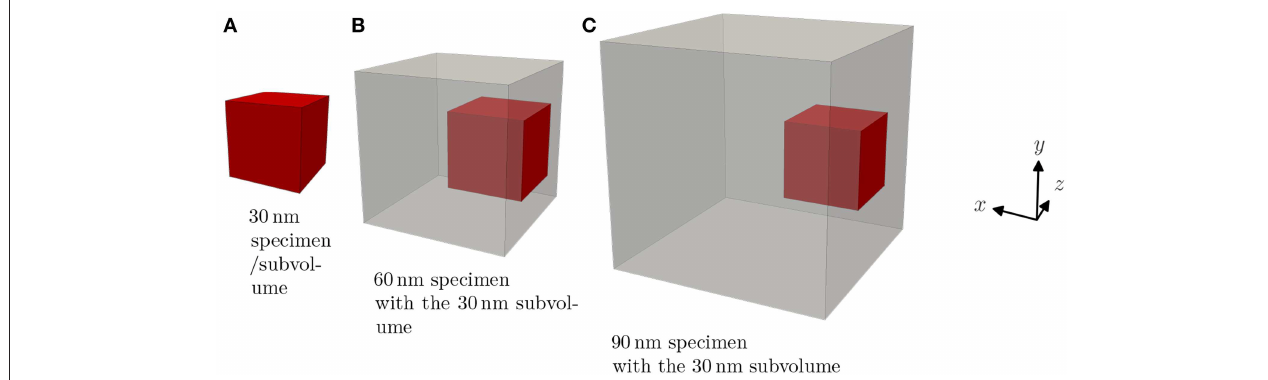
FIGURE 1 | Sample geometries considered in this work. The subvolumes used for the classification of the specimen size are shown in red. Their size is 30nm for all specimen sizes. (A) 30nm specimen/subvolume. (B) 60 nm specimen with the 30 nm subvolume. (C) 90 nm specimen with the 30nm subvolume.